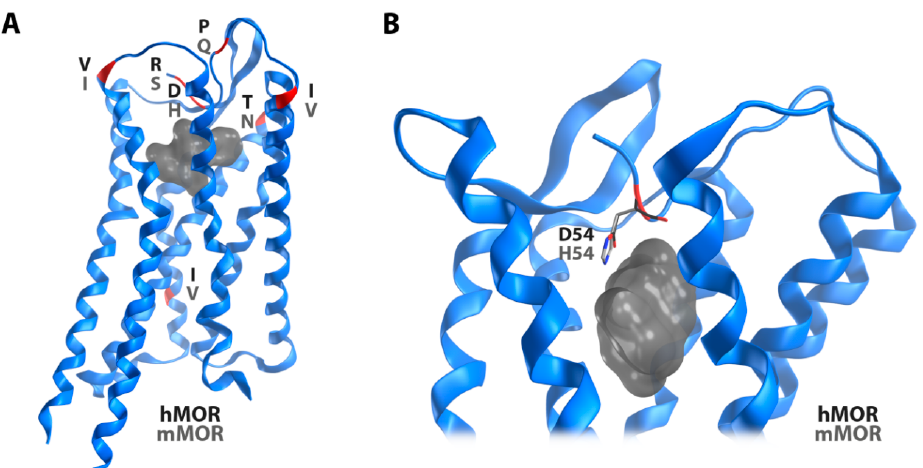
Figure 3. The murine (PDB ID: 5C1M) and the human MOR model differ only in seven amino acid residues as illustrated in red ( A ). Only one of these differing residues is directly pointing to the ligand binding site ( B , grey surface). Whereas a histidine residue is at position 54 in the murine MOR, the human receptor has an aspartic acid at this position.